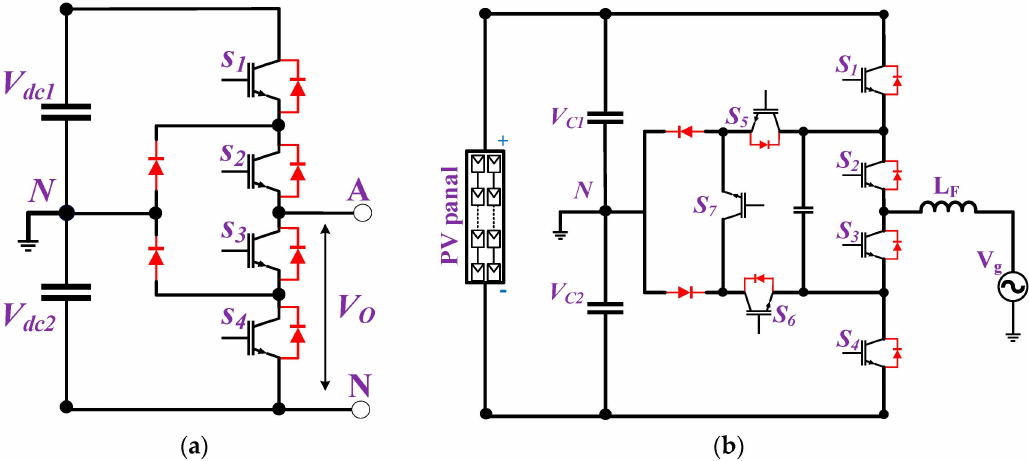
Figure 2. Single-phase circuit of NPC topology. ( a ) A three-level NPC [37]; ( b ) a five-level ANPC